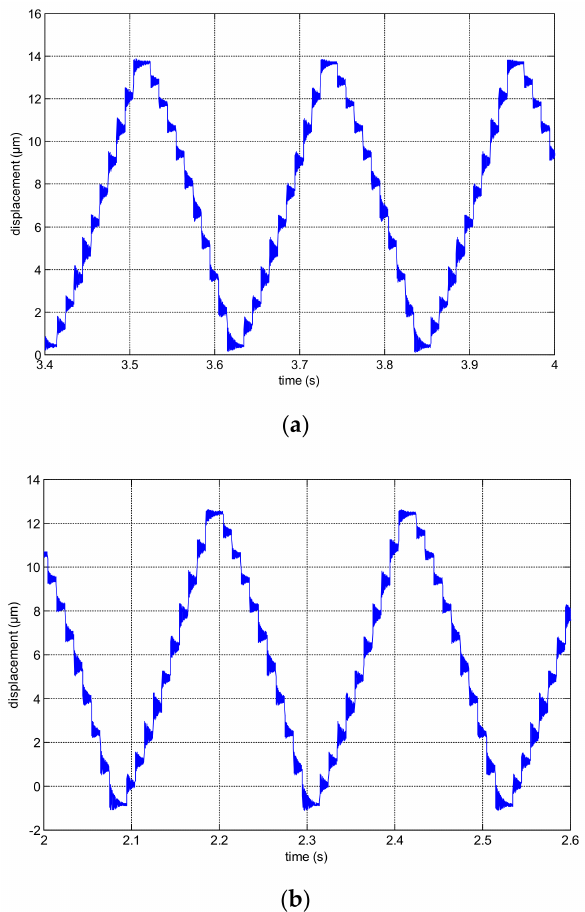
Figure 32. The output displacements of the mechanical stage: ( a ) the output displacement exited by the power amplifier using high-voltage operational amplifiers; ( b ) the output displacement exited by the power amplifier using general operational